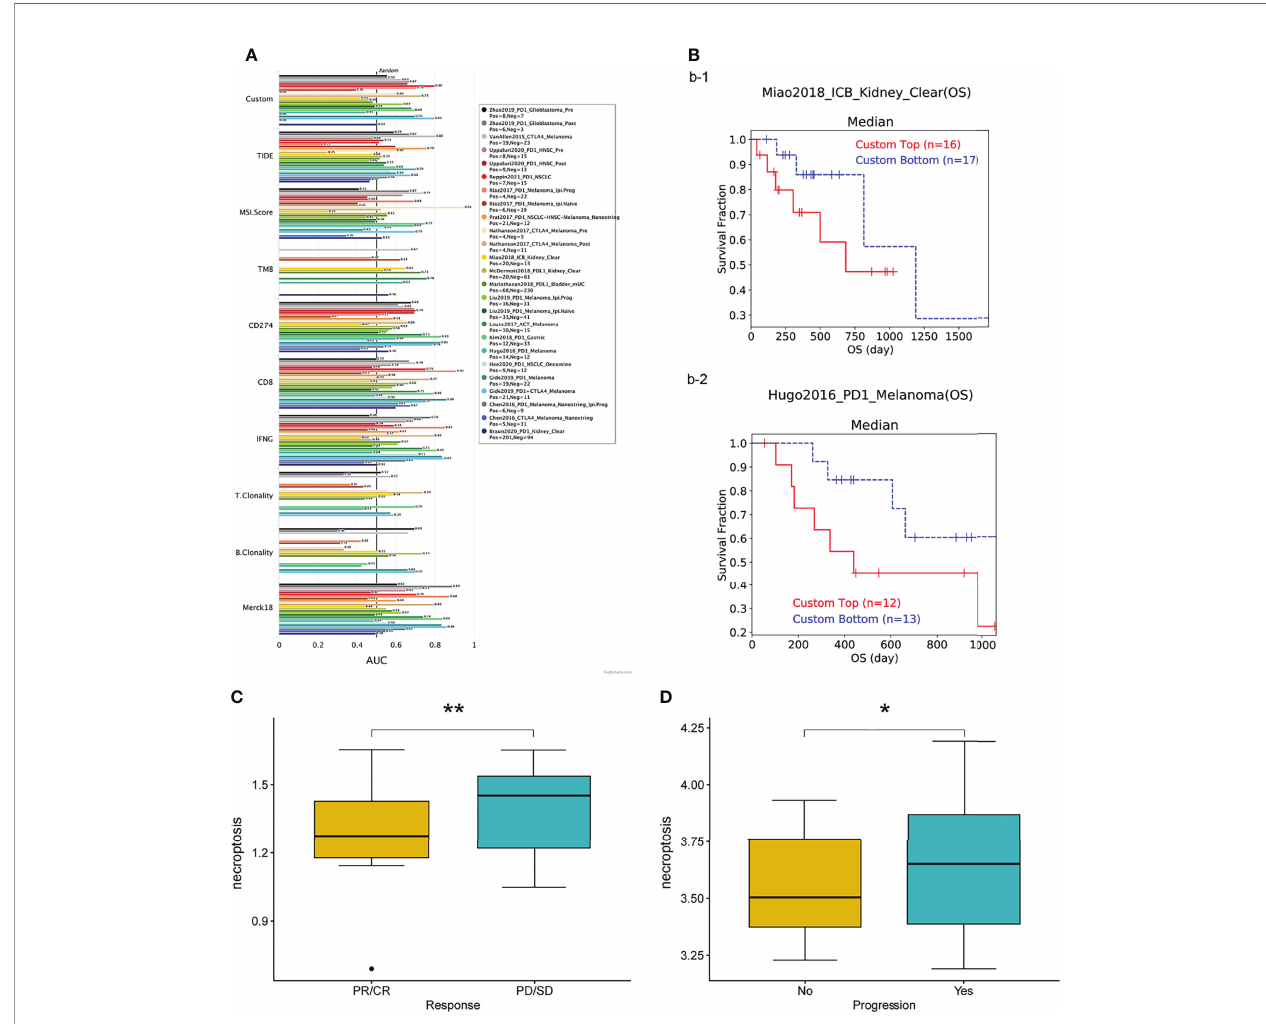
FIGURE 9 | (A) Bar plot showing the biomarker relevance of necroptosis scores compared to standardized cancer immune evasion biomarkers in immune checkpoint blockade (ICB) sub-cohorts. The area under the receiver operating characteristic curve (AUC) was used to assess the predictive ef fi cacy of test biomarkers for determining IBC response to TCGA for different cancer types. (B – D) Patients with high scores exhibit poorer prognostic outcomes after immunotherapy. CR, complete responses; PR, partial responses; PD, progressive disease; SD, stable disease. * P < 0.05, ** P <